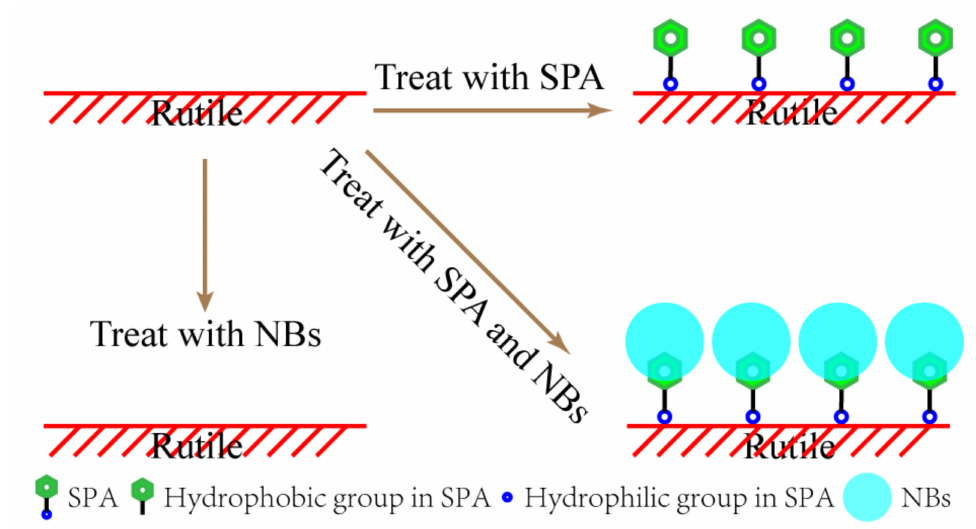
Figure 6. Adsorption model of SPA and nanobubbles on rutile